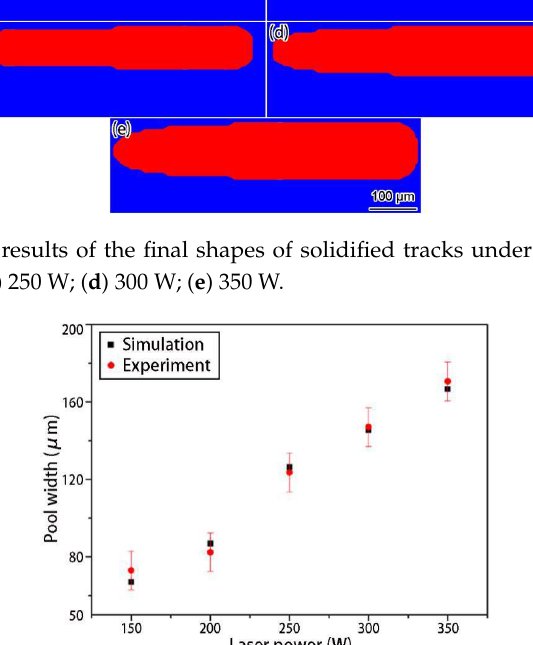
Figure 14. Comparison of simulation and experimental [35] solidified track widths under different laser powers.